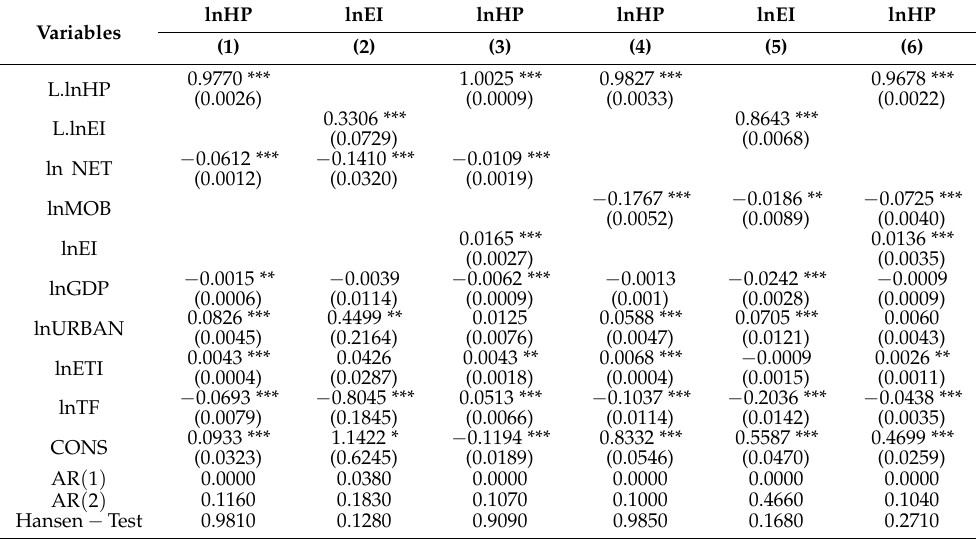
Table 6. Mechanism test results of energy consumption intensity as the mediating